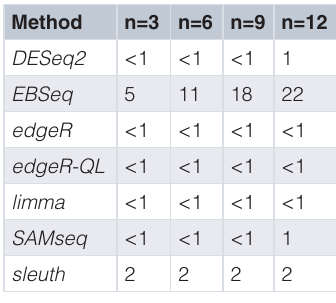
Table 3. Compute time of methods for differential transcript expression (DTE) rounded to the nearest minute by per-group sample size. Compute time includes data